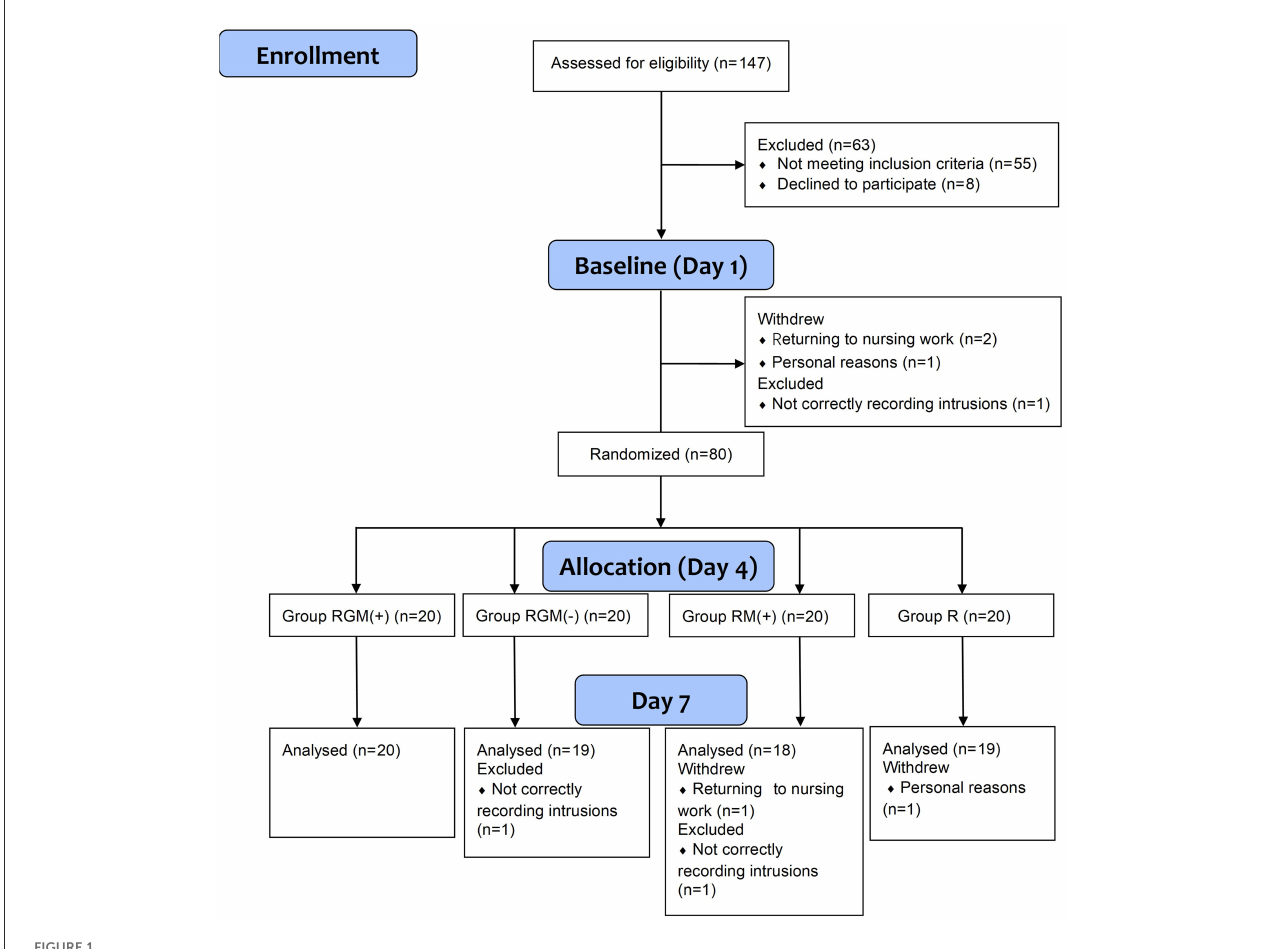
FIGURE1 Flow diagram of this